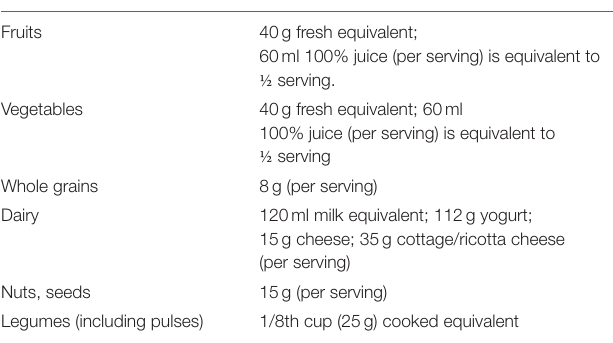
TABLE 2 | Levels for food groups to